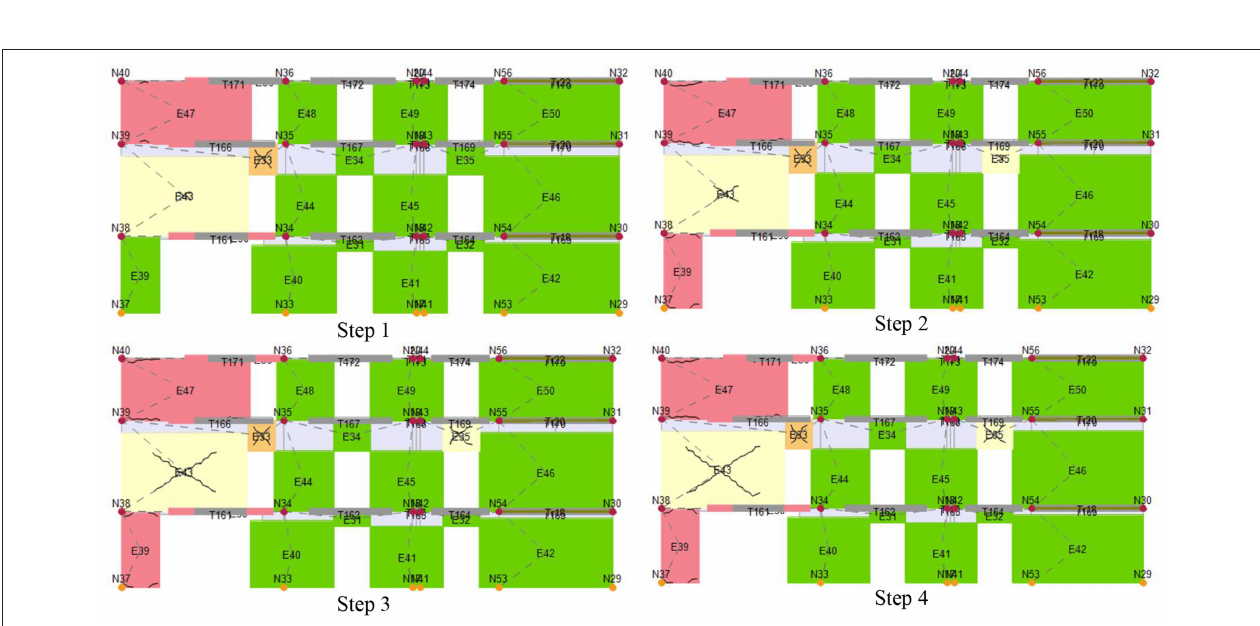
FIGURE 5 | Progressive damaging state of piers and spandrels of the P8 wall in the analysis n. 15 (green: no damage, pink: compression-bending moment plastic, light yellow: shear plastic, orange: shear failure).